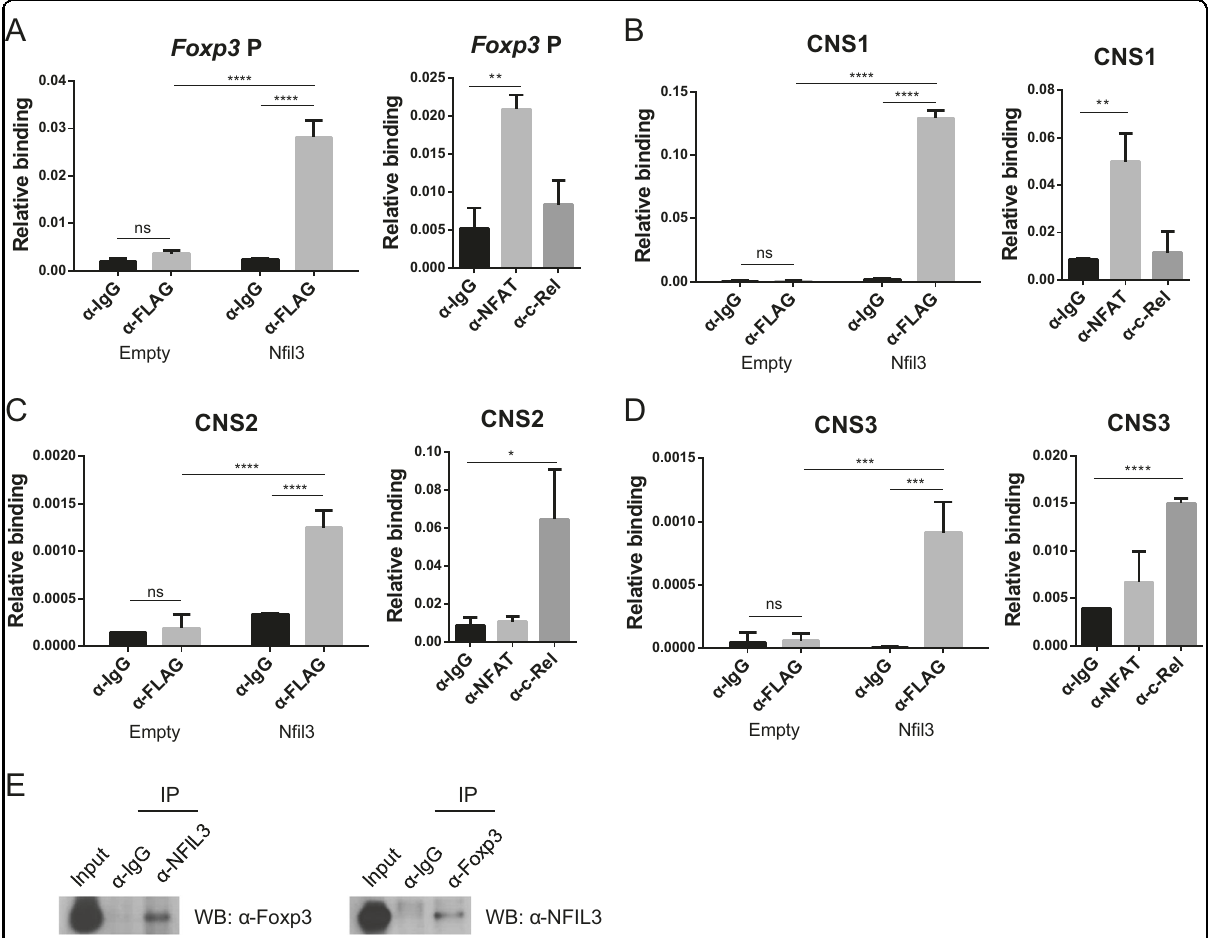
Fig. 5 NFIL3 binds to both the Foxp3 locus and Foxp3 protein. Binding of NFIL3-FLAG to the promoter ( a ), CNS1 ( b ), CNS2 ( c ), and CNS3 ( d ) of the Foxp3 locus in nuclear extracts from control or N fi l3 -Flag-overexpressing Treg cells was measured by chromatin immunoprecipitation assay. Data are pooled from three individual experiments (left panel). Binding of NFAT and c-Rel was used as the control (right panel). e HEK293T cells were transfected with pCMV- N fi l3 or pCMV- Foxp3 . Cell lysates were immunoprecipitated with anti-NFIL3, anti-Foxp3, or control IgG antibodies. Then, proteins were immunoblotted using anti-Foxp3 or anti-NFIL3 antibodies. IP, immunoprecipitation; WB western blot. Error bars represent the SD. The signi fi cance of the differences between groups was determined by two-way ANOVA. * P < 0.05, ** P < 0.01, *** P < 0.001, and **** P < 0.0001, n.s. not signi fi